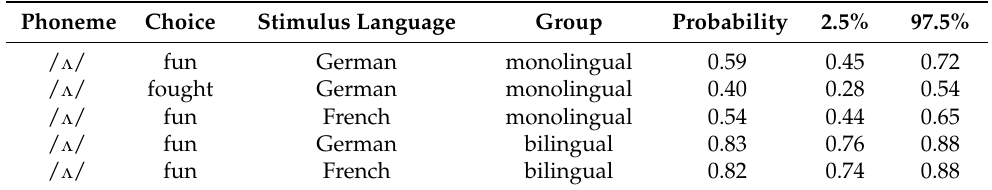
Table 5. Most probable responses given / 2 / in French and German by L1 English monolinguals and L1 English bilinguals.